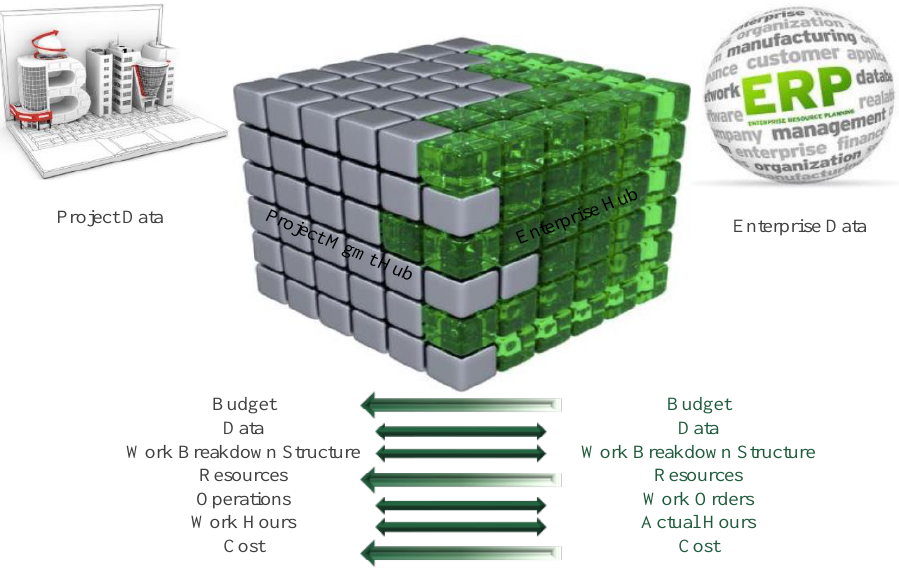
Figure 5. ERP and BIM data exchange.